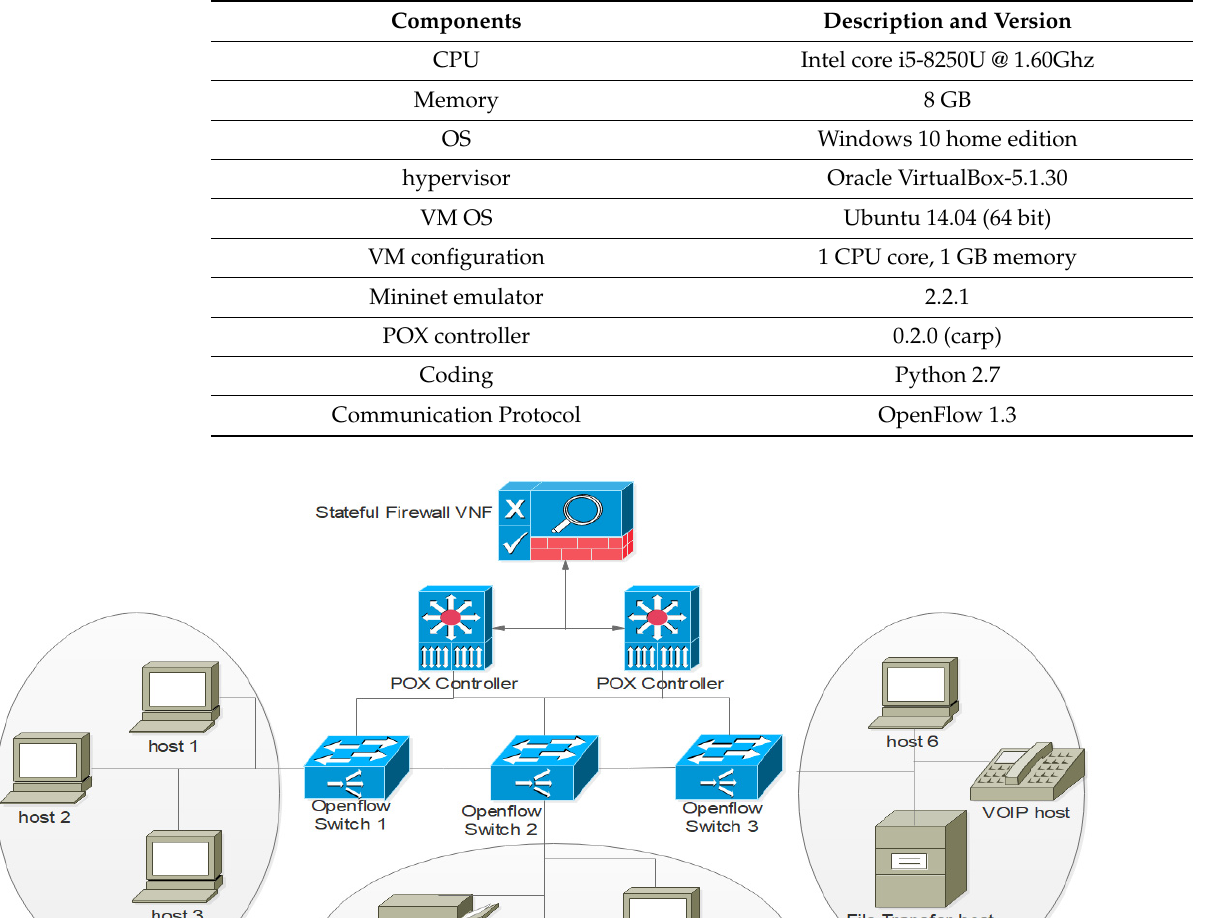
Table 1. Hardware and software configuration and version.